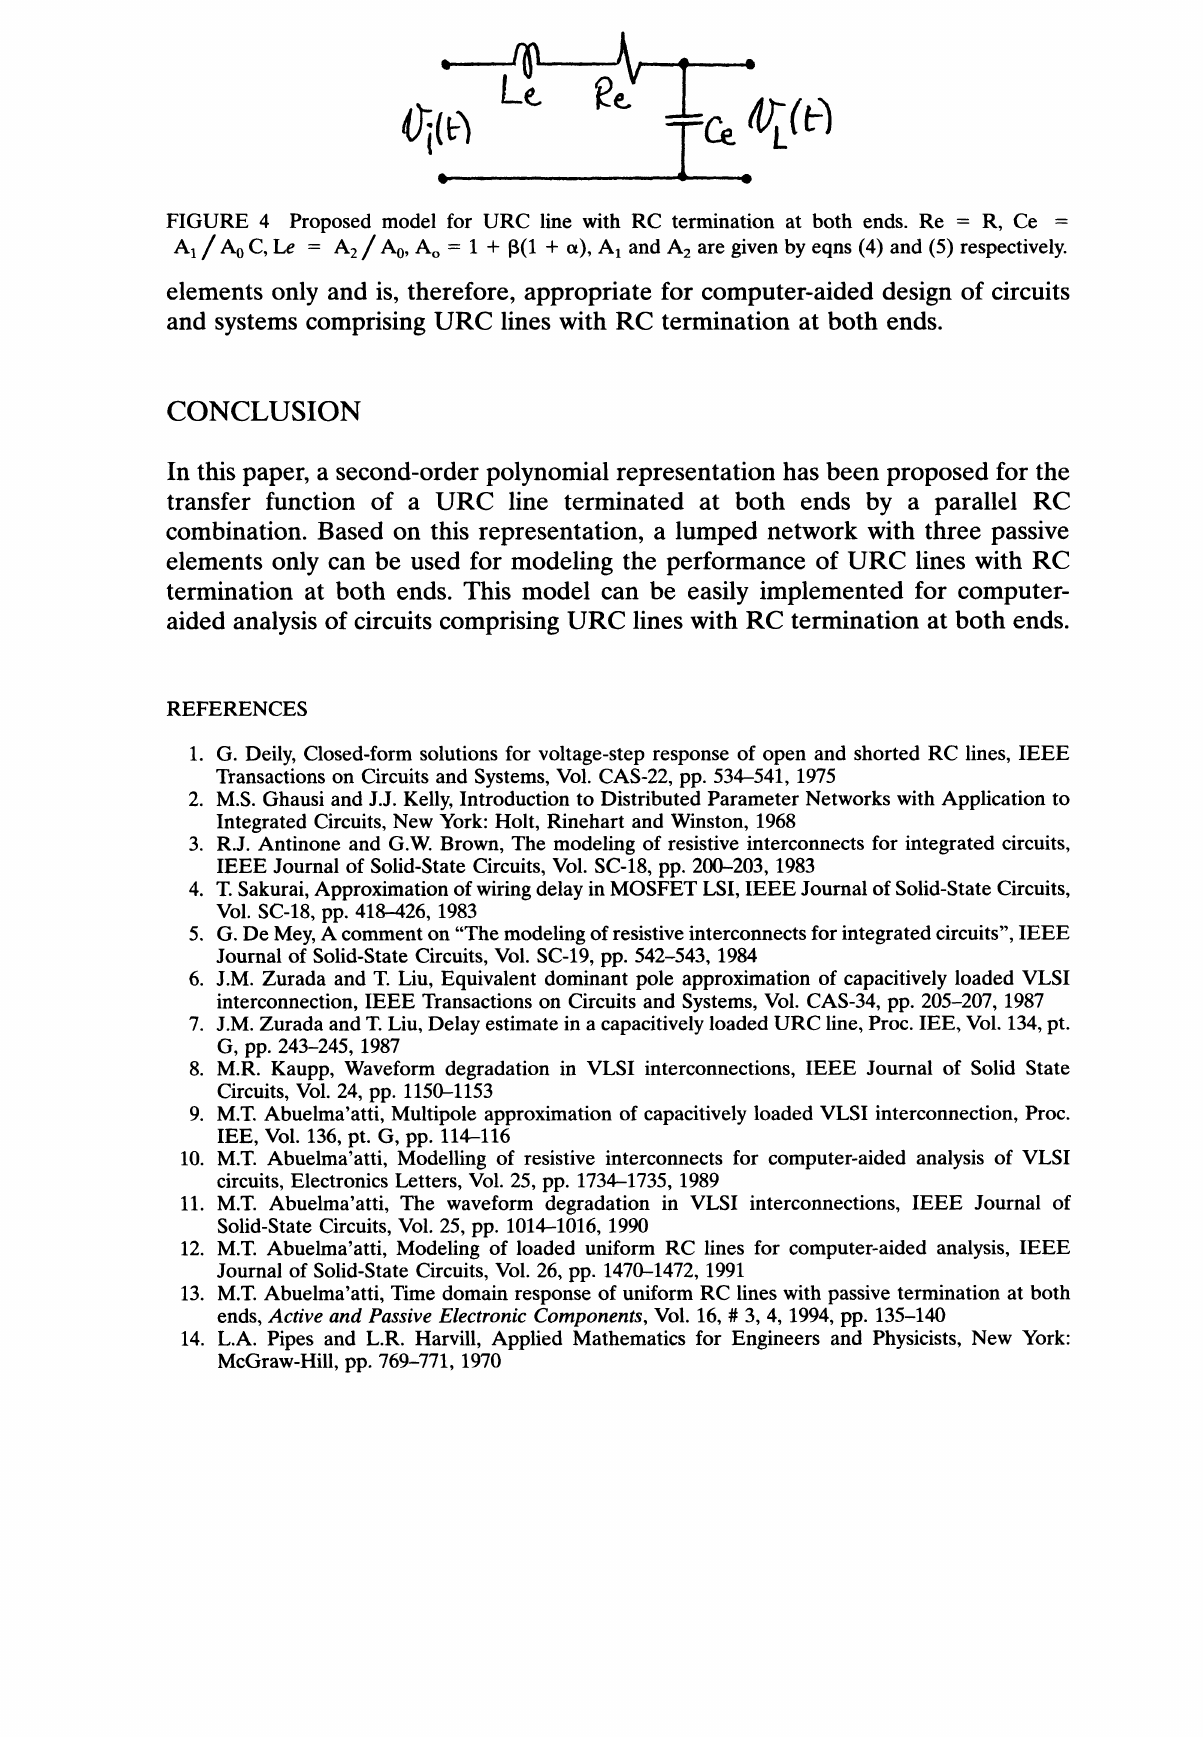
FIGURE 4 Proposed model for URC line with RC termination at both ends.